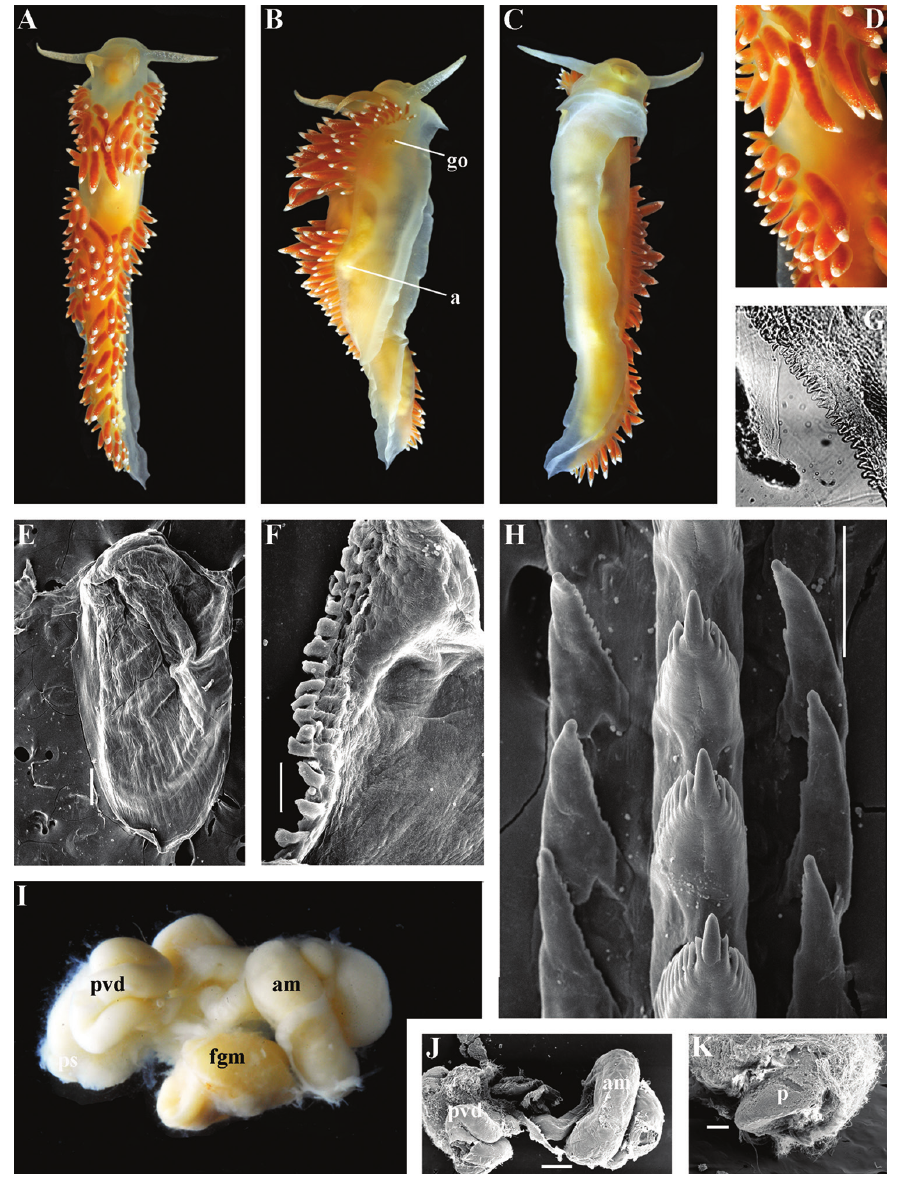
Figure 20. Coryphella verrucosa (M. Sars, 1829), long cerata (“rufibranchialis”) morphotype. ZMMU Op-521, Barents Sea, Oskara Bay, living specimen 42 mm in length (live): A dorsal view B lateral view C ventral view D details of cerata E jaw, SEM F details of masticatory process of jaw, SEM G details of masticatory process of jaw, light microscopy H radular teeth, posterior part, SEM I reproductive system, light microscopy J reproductive system, SEM K penis partially everted, SEM. Abbreviations: a anus am ampulla fgm female gland mass go genital opening p penis pvd prostatic vas deferens. Scale bars: E bar = 300 μm; F, K = 30 μm; H = 100 μm; J = 1 mm. Photos and SEM images by T.A. Korshunova, A.V.